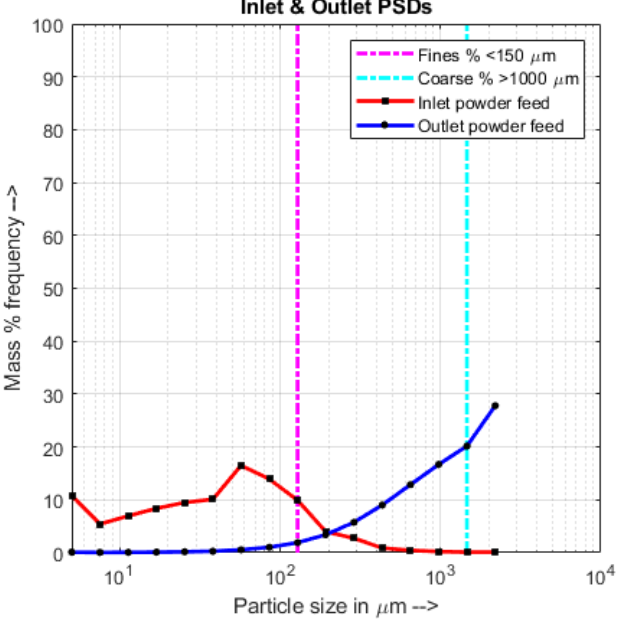
Figure 11. Kumar et al., 2016 [19] PSD trend obtained from a PBM pulse tracer study for favorable granulation case.